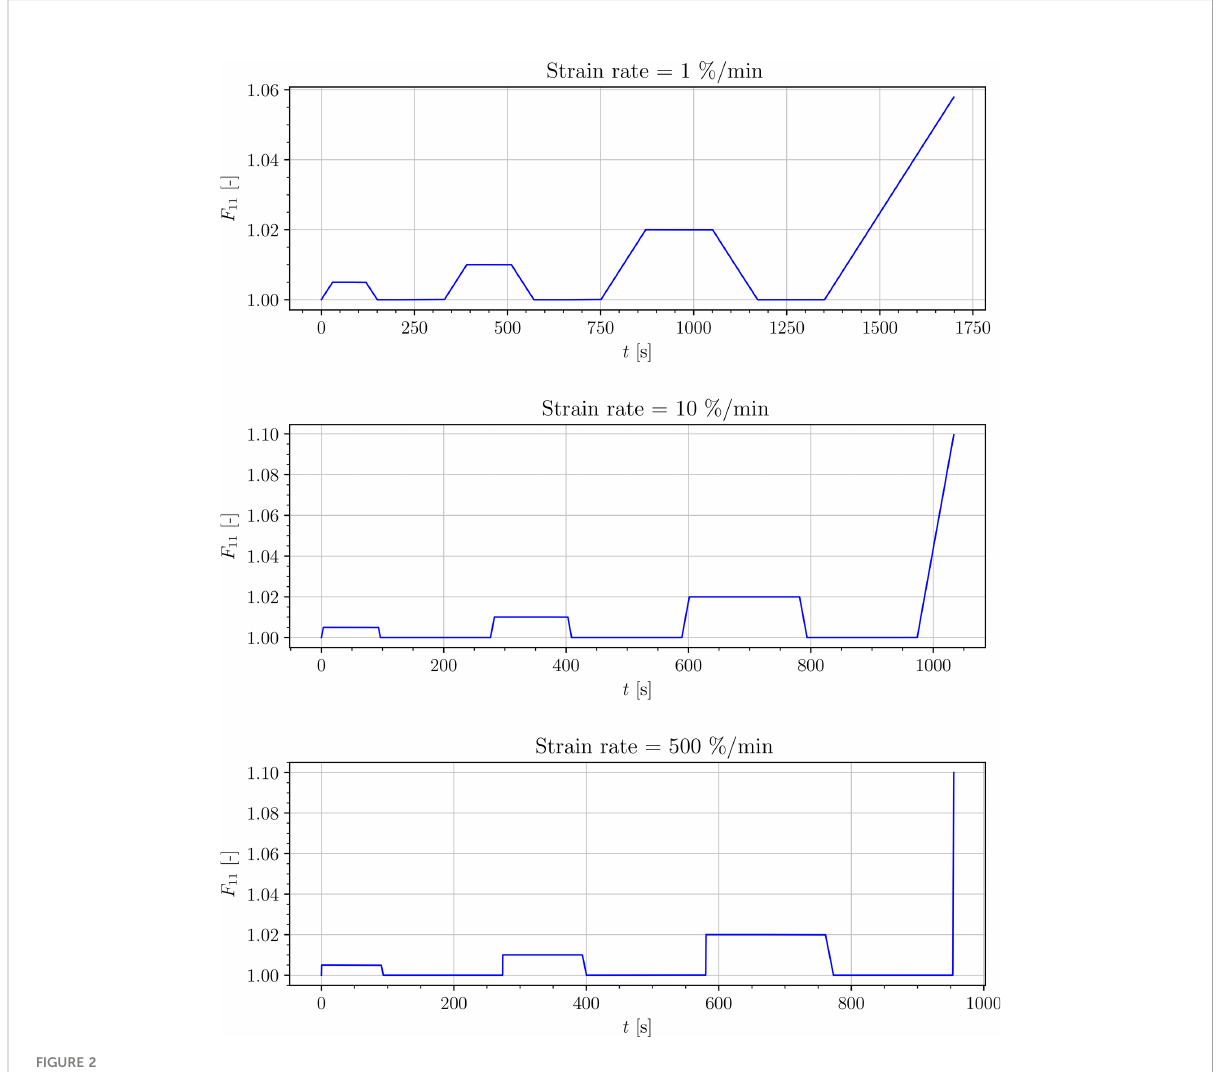
FIGURE 2 Strain-driven cyclic